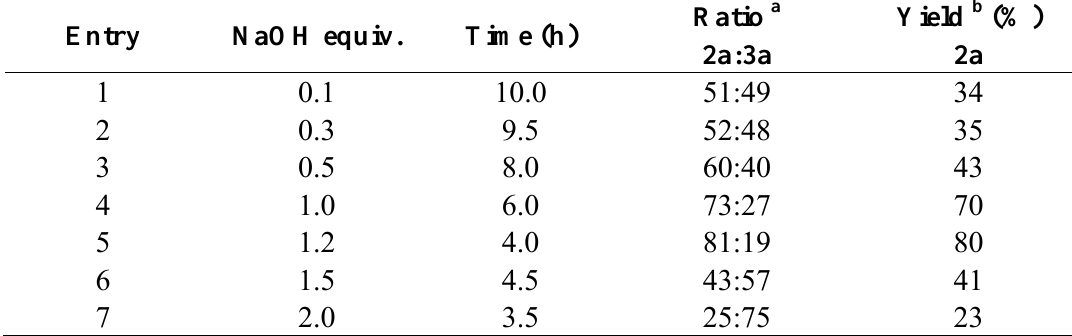
Table 3. The effect of NaOH stoichiometry on the monohydrolysis of 1a .